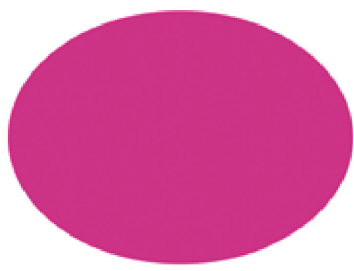
Figure 10: Implicit surface.